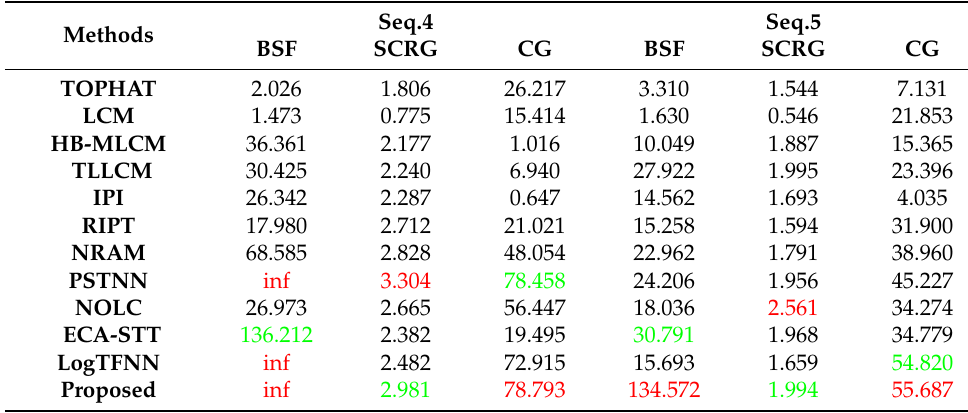
Table 5. Measurements for twelve detection